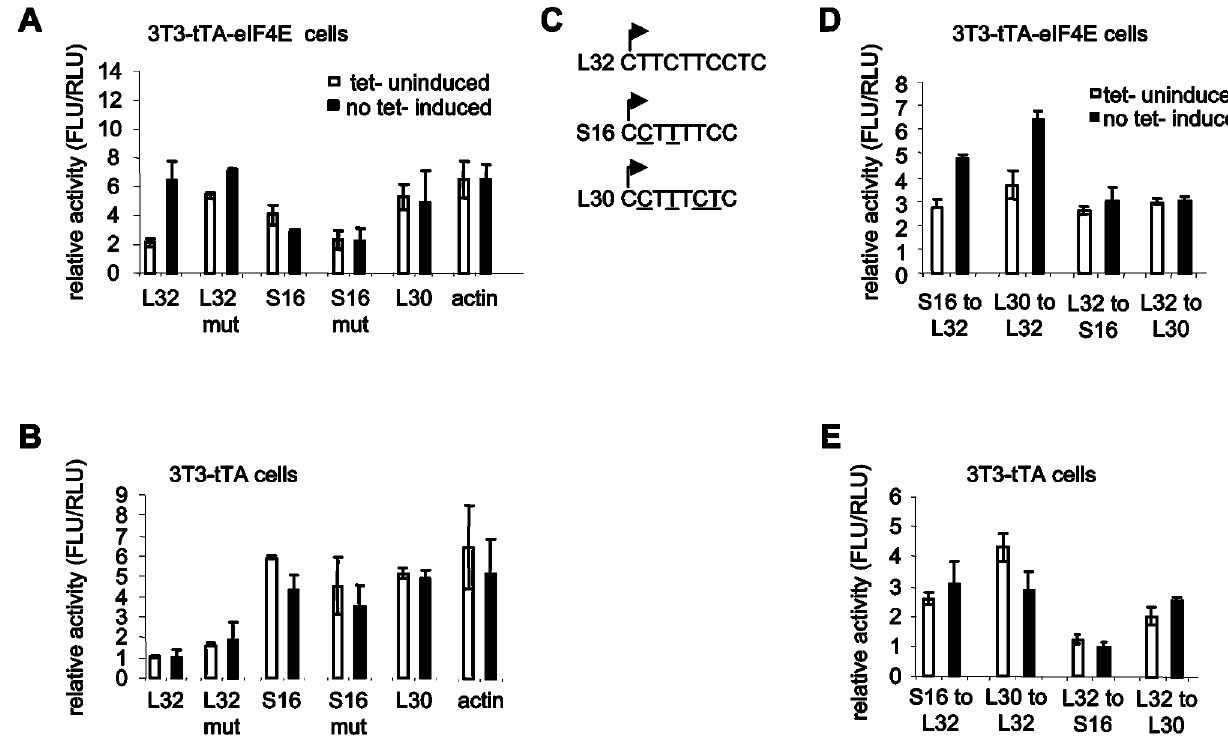
Figure 6. eIF4E and TOP mRNA translation. A) DNA segments encompassing the promoters and 5 9 UTRs of L32, L32 mut (non-TOP), S16, S16 mut (non-TOP), L30 and b -actin were subcloned upstream of the firefly luciferase gene. 3T3-tTA-eIF4E cells were transfected with the various firefly luciferase reporters and a renilla luciferase reporter, which was used for transfection efficiency, and were cultured for 32 hr. Tetracycline containing medium was then replaced by a tetracycline free medium for 16 hr; control (non-induced) cells were cultured in parallel with tetracycline. Firefly luciferase activity (FLU) was measured and normalized against renilla luciferase activity (RLU). B) Luciferase activity of the reporters was measured in the parental cell line 3T3-tTA as described in (A). C) TOP sequences of L32, S16 and L30 are depicted. The arrows indicate the transcriptional start site. The nucleotide changes between L32 and S16 and L32 and L30 are underlined. D) Mutated reporters were generated by exchanging the TOP sequences of L32, S16 and L30. Luciferase assays were performed as described in (A). E) Luciferase activity of the reporters was measured in the parental cell line 3T3-tTA as described in (A). Assays were carried out in triplicate. Luciferase activities represent an average obtained from three independent